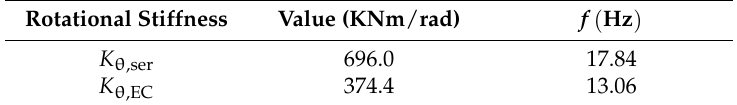
Table 4. Results from modal analysis for the three-dimensional (3D) portal frame model. Rotational Stiffness